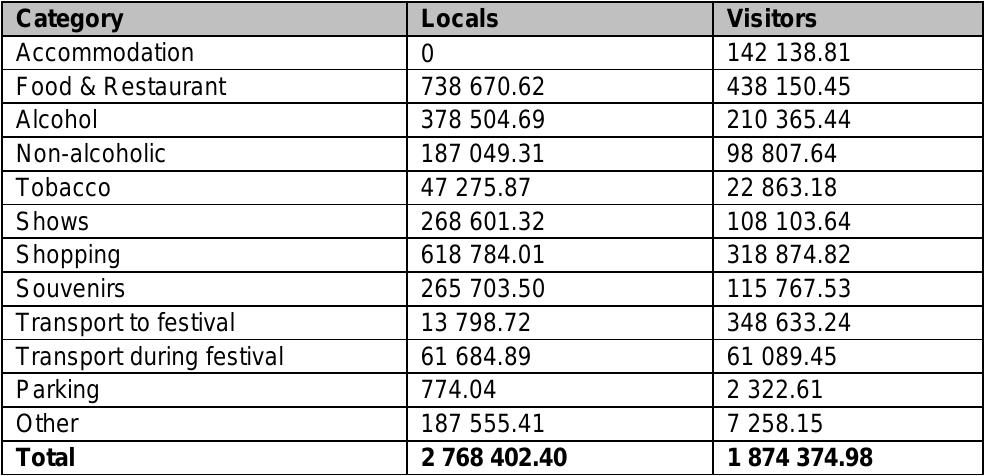
Table 5: Estimated local expenditure (R) according to category for the festival